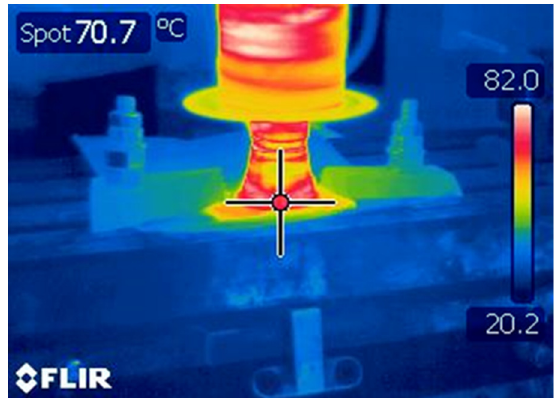
Fig. 7. Infrared photography for optimum